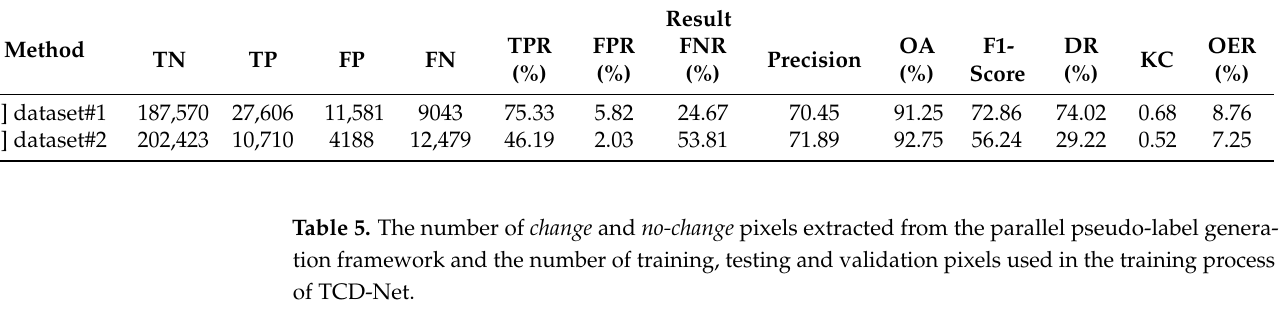
Table 4. The accuracy of the CD framework proposed in [2] for dataset#1 and dataset#2.